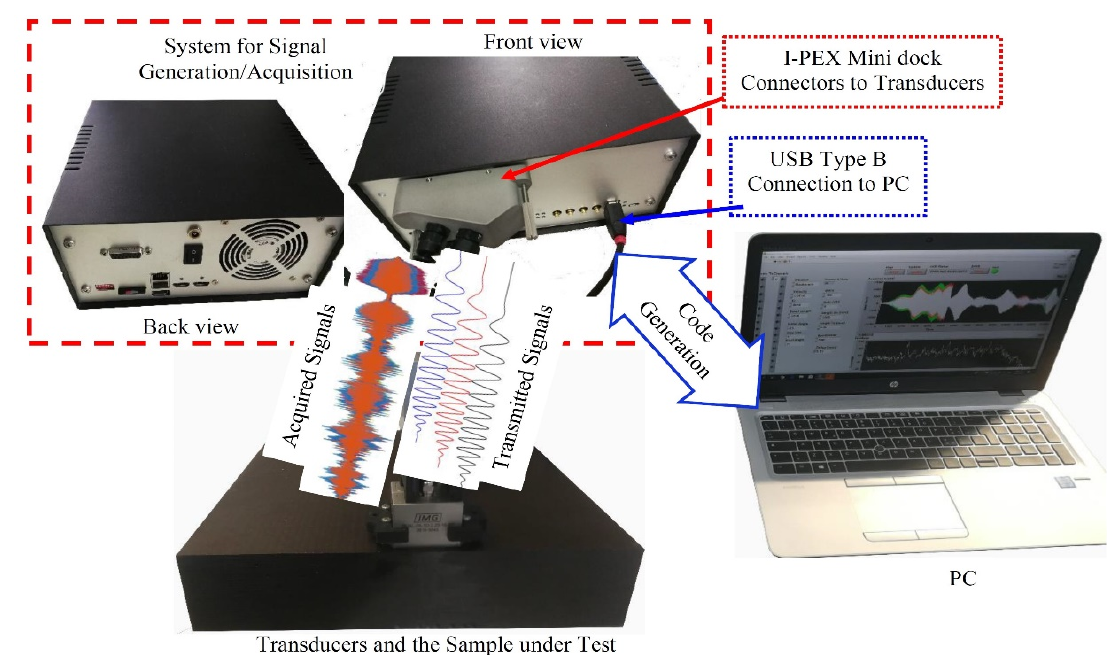
Figure 1. Schematic representation of the pulse-compression-based phased-array (PuC-PA) ultrasonic testing system: coded signals are generated in a personal computer and fed to the system for signal generation and acquisition; the ultrasonic signals are transmitted and received with separate transducers in a pitch–catch configuration, and the acquired and digitalized signals are sent back to the computer for processing and imaging purposes.